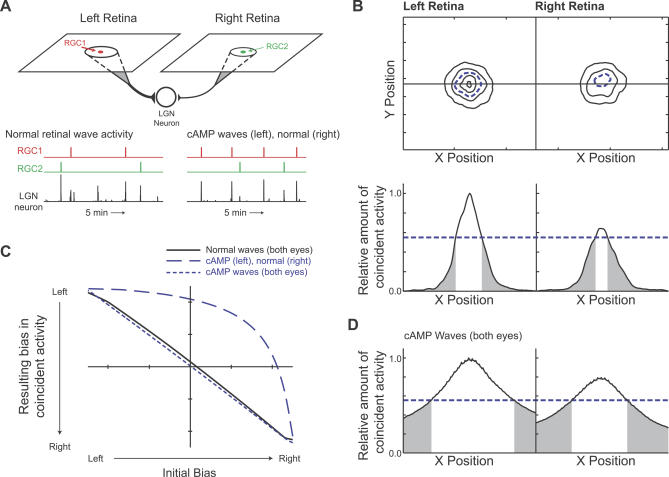
Observed “Hebbian” Plasticity Leads to Robust Retinogeniculate Refinement over Many Retinal Waves(A) Model schematic of localized areas in two retinas providing input to a single LGN neuron. Below: the LGN neuron activity is the sum of RGC activity over its inputs; a RGC from each eye and the LGN activity is shown for 5 min during a simulation with normal retinal waves (left) and a simulation in which the left eye has activity simulating raised cAMP levels, which results in increased wave size and frequency (right) [40].(B) The amount of coincident activity between RGCs and the LGN neuron as a function of two-dimensional RGC position in the retina (top, contour plot) and a one-dimensional slice through the middle of each retina (bottom). The dashed horizontal line in each figure illustrates that for a given cutoff between strengthening and weakening, a larger number of RGCs in the left eye (compared with the right eye) will be strengthened in retinotopically appropriate positions. As a result, no matter where this cutoff is, more connections will be weakened (shaded areas) that originate from the right eye.(C) The results of simulations over a range of initial bias in connection strength between the eyes, demonstrating that the initial strength of connection biases competition in favor of the more strongly connected eye. Simulations were run using normal waves (solid line), as well as a condition simulating elevated cAMP levels in one eye (dashed line) or both eyes (dotted line).(D) The amount of activity overlap for simulations of elevated cAMP levels in both eyes (same format as in [B], bottom), showing that increasing wave size and frequency results in normal eye segregation as shown in (C), but less retinotopic refinement.